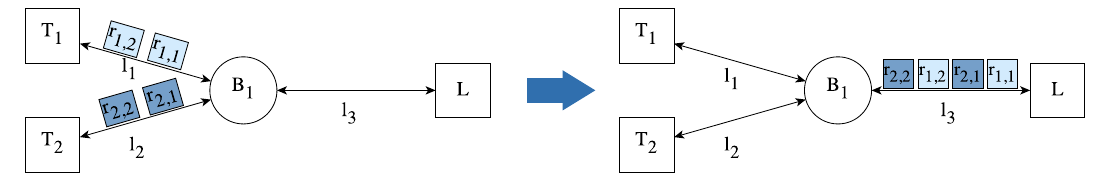
Figure 8. Example of interleaving replicas when using the approach A of the PTRF mechanism to tolerate temporary faults in the